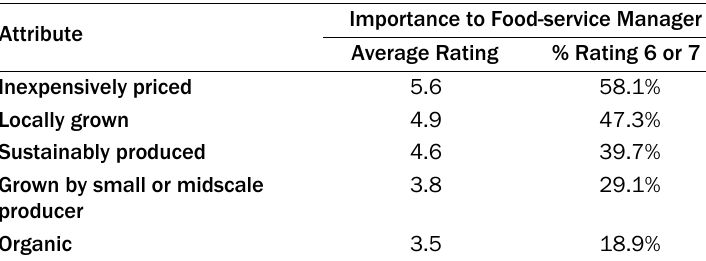
Table 3. Importance of Various Attributes to Food Service Managers and